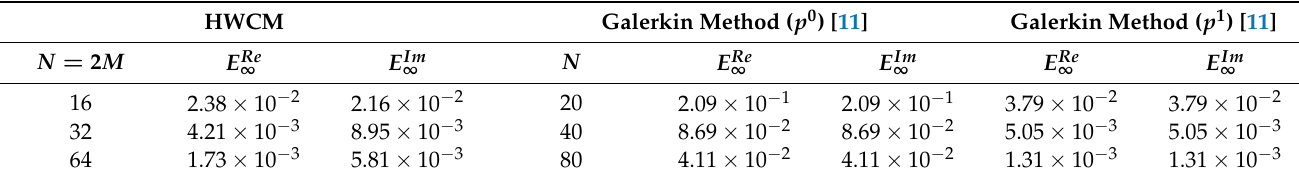
Table 4. Comparison of different methods at ∆ τ = 0.001 and T = π 2 for Test Problem 1. HWCM